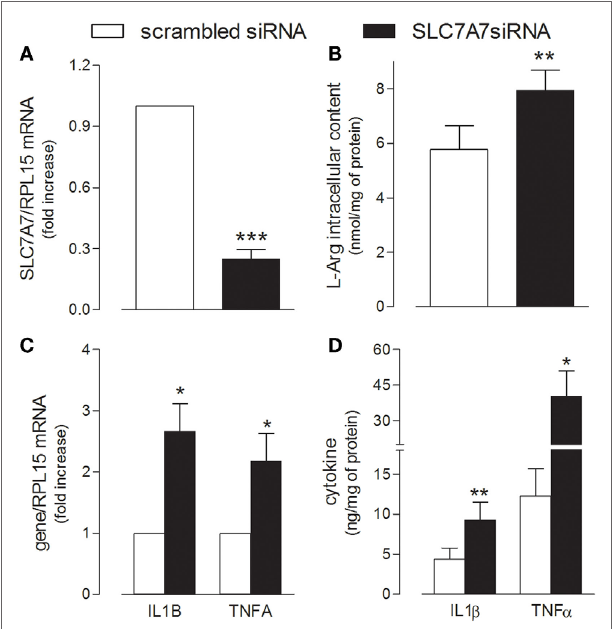
FigUre 1 | THP-1 cells, routinely grown in the presence of 1 mM extracellular arginine, were transfected with scrambled or SLC7A7 short interference RNA (siRNA) in the presence of 80 nM phorbol-12-myristate- 13-acetate (PMA), as described in Section “Materials and Methods”; after 96 h, cells were analyzed for the expression of SLC7A7 mRNA with RT-qpolymerase chain reaction (RT-qPCR) (a) and for intracellular arginine content by means of HPLC/ESI-MS-MS (B) . In the same cells, the production and release of IL1 β and TNF α were monitored with RT-qPCR (c) and ELISA assay (D) , respectively. Data are mean ± SEM of four different determinations, each performed in duplicate. * p < 0.05, ** p < 0.01, *** p < 0.001 vs. scrambled siRNA with One sample t -test (a,c) or Student’s t -test for paired samples (B,D)